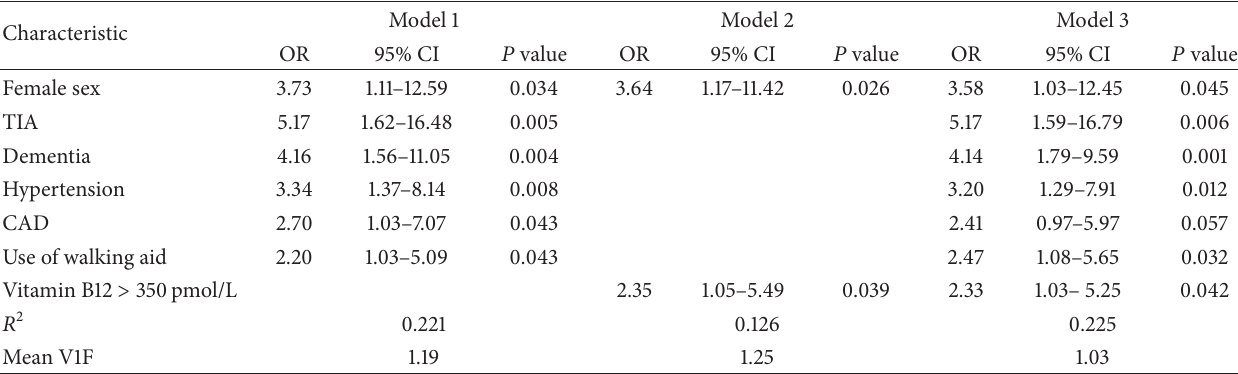
Table 5: Clinical and laboratory characteristics independently associated with poststroke hip